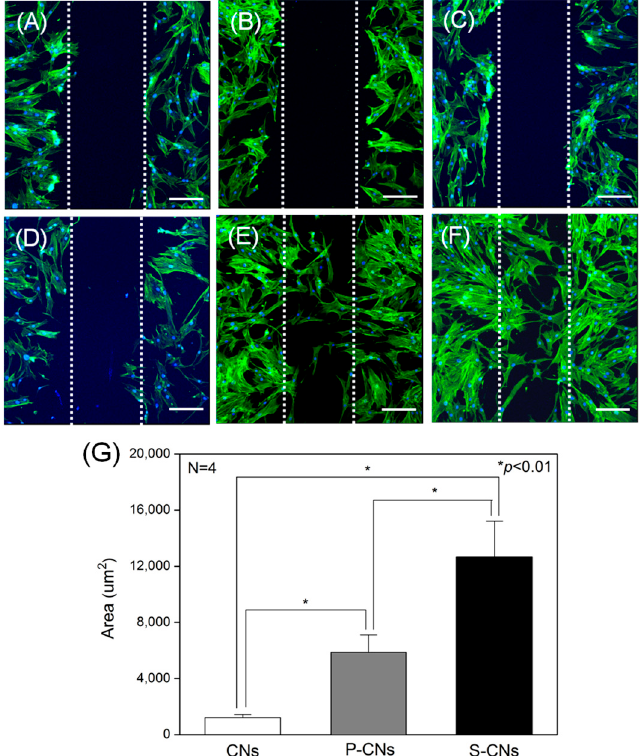
Figure 6. hMSCs were cultured on CNs in an in vitro wound-healing model. ( A – C ) Dotted white lines represent initial wound edges at 0 h for neutralized CNs ( A ), P-CNs ( B ) and S-CNs ( C ); ( D – F ) After 48 h, cells on neutralized CNs ( D ), P-CNs ( E ) and S-CNs ( F ) were stained for actin filaments (green) and nuclei (blue) using FITC-phalloidin and DAPI, respectively. Scale bar: 50 μ m; ( G ) Quantitative analysis of the migrated area of hMSCs from ( D – F ).